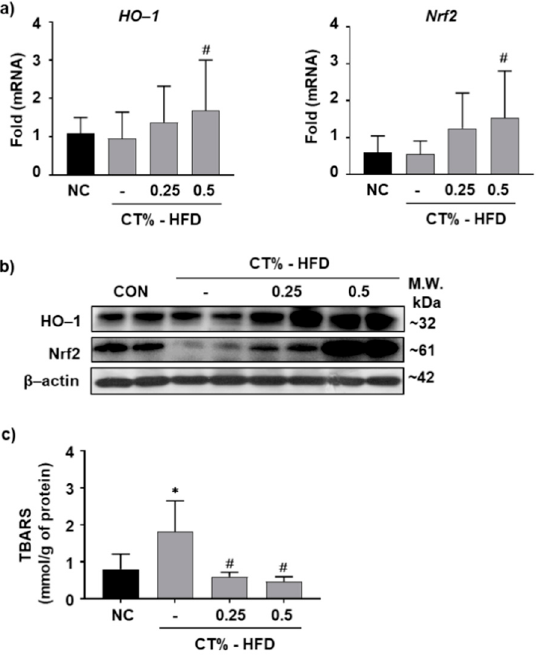
Figure 5. Antioxidant effect of CT on HFD-fed mice. One week after acclimatization, C57BL/6J mice were fed HFD mixed with 0.25% and 0.5% CT for 7 weeks. The liver mRNA expression level of ( a ) heme oxygenase-1 (HO-1) and nuclear factor, erythroid 2 like 2 (Nrf2) were analyzed by RT-qPCR. ( b ) The protein expression levels of HO-1 and Nrf2 were estimated by western blotting and normalized to β -actin. ( c ) The level of thiobarbituric acid reactive substances (TBARS) were analyzed in liver lysate. NC: normal chow; (-): HFD; CT-HFD; CT treated HFD. Values are mean ± SE. AVOVA p -value: * <0.05 vs. NC group; # <0.05 vs. HFD-fed group.